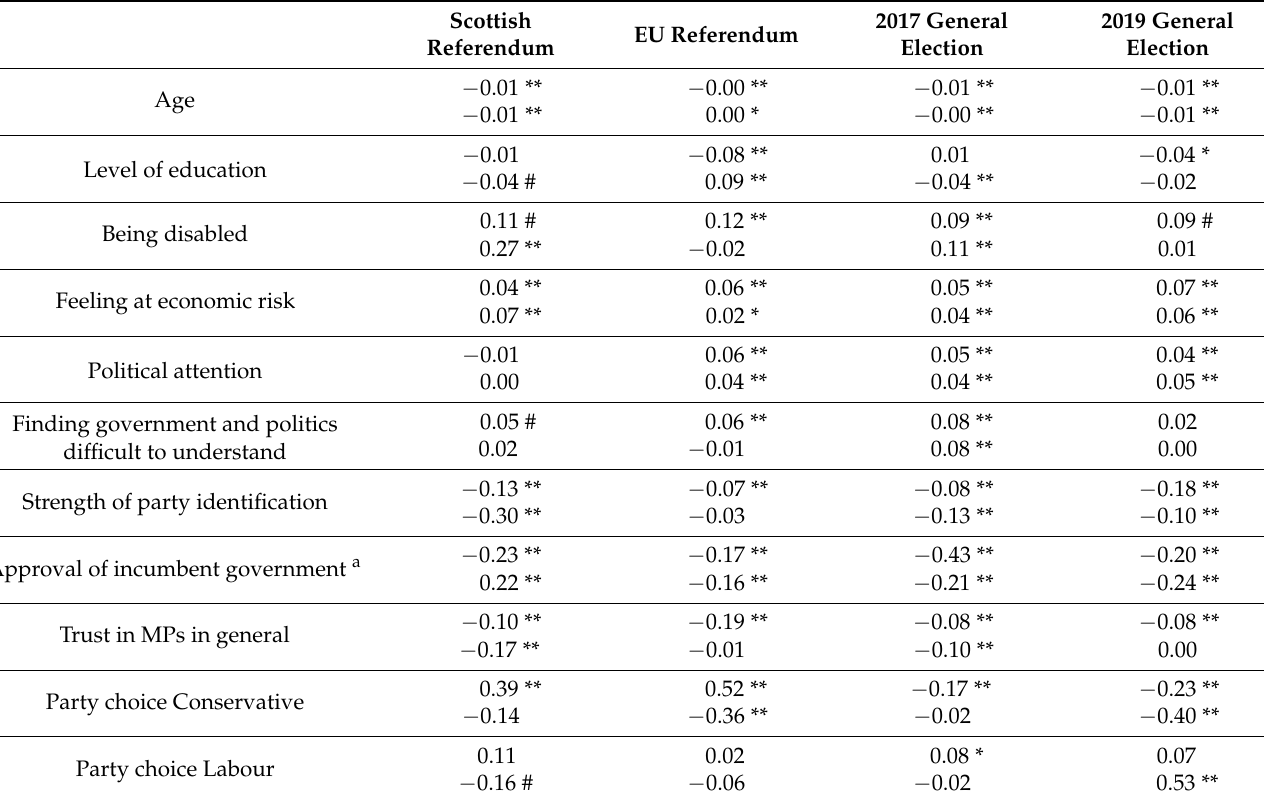
Table 4. A comparison of regression models predicting both prospective and retrospective evaluations of